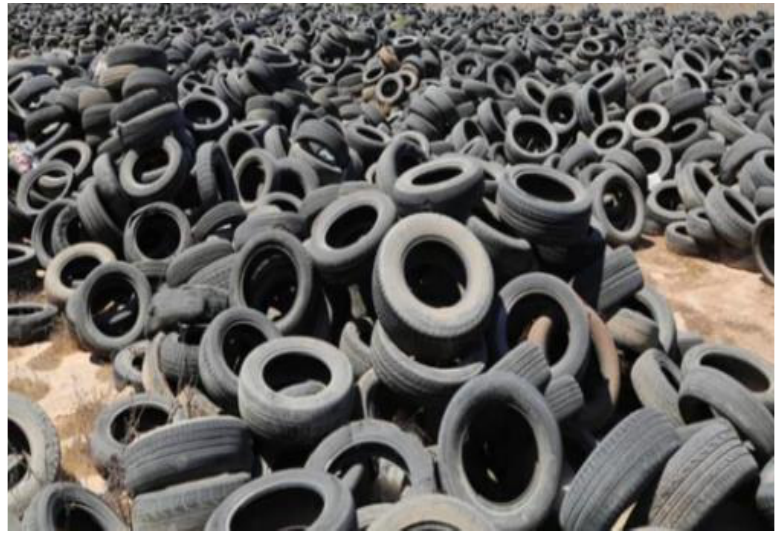
Figure 2. Waste rubber tires [8].